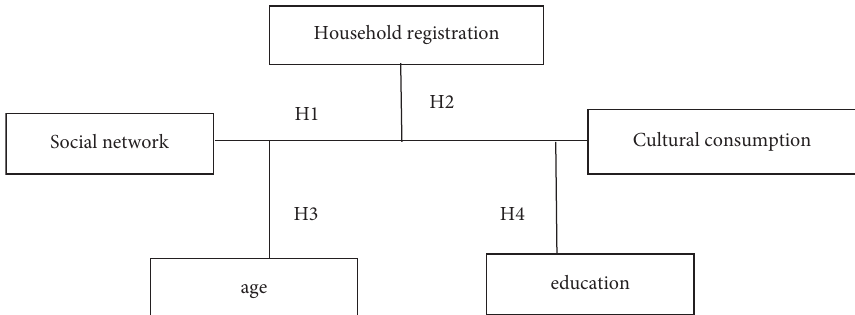
Figure 2: A theoretical model of influencing factors of individual characteristics on cultural